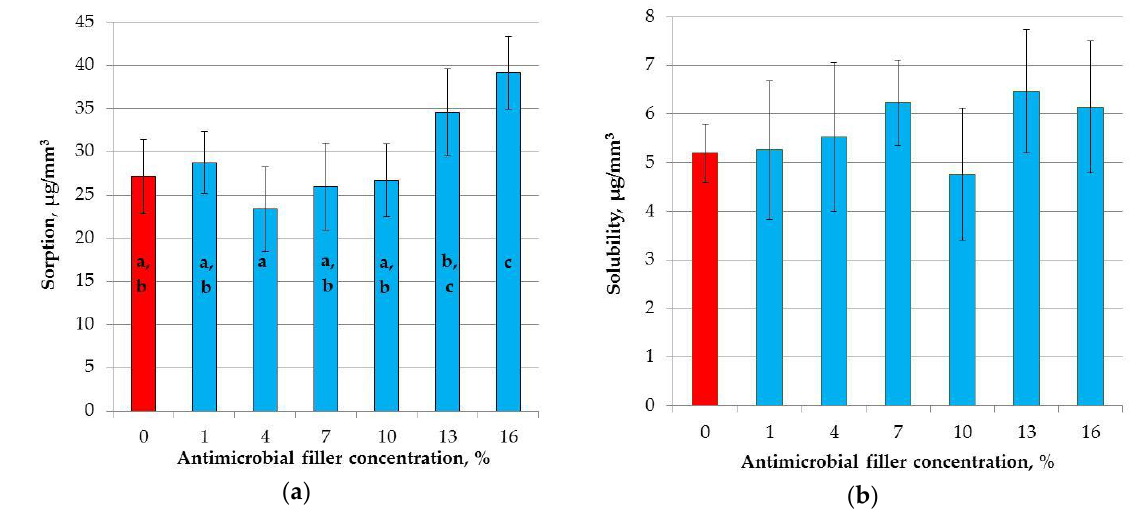
Figure 8. Mean values with standard deviations of sorption ( a ); and solubility ( b ), different lowercase letters show significantly different results at the p < 0.05 level.